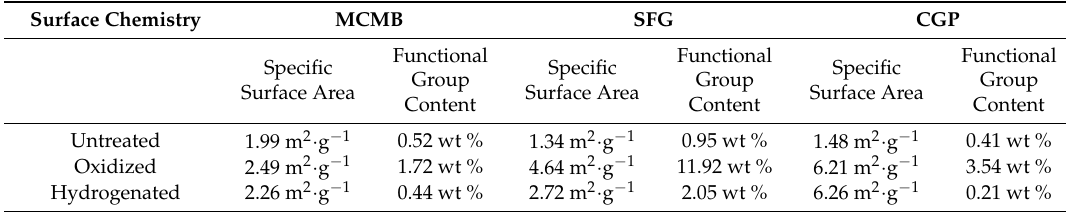
Table 1. Gas sorption-derived specific surface area measurements and functional group content of chemically modified MesoCarbon MicroBeads (MCMB), Synthetic Flakes of Graphite (SFG), and ConocoPhillips Graphite Particles (CGP) graphite electrode particles. Functional group content was derived from thermogravimetric analysis (TGA).